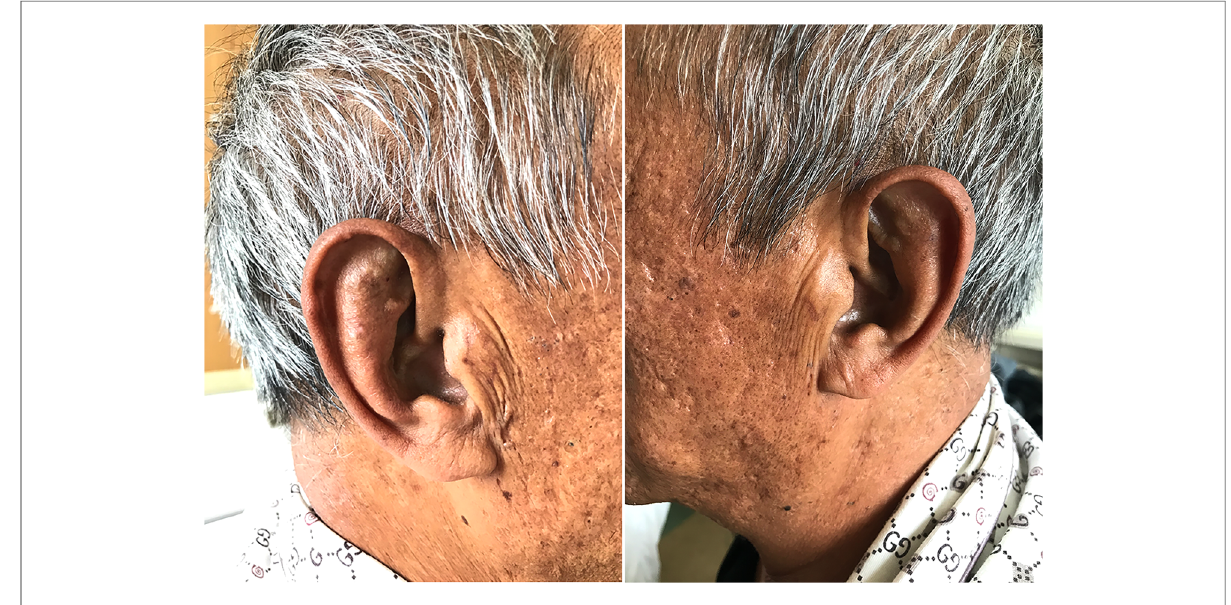
FIGURE 1 Melanin deposition in the patient ’ s auricle and